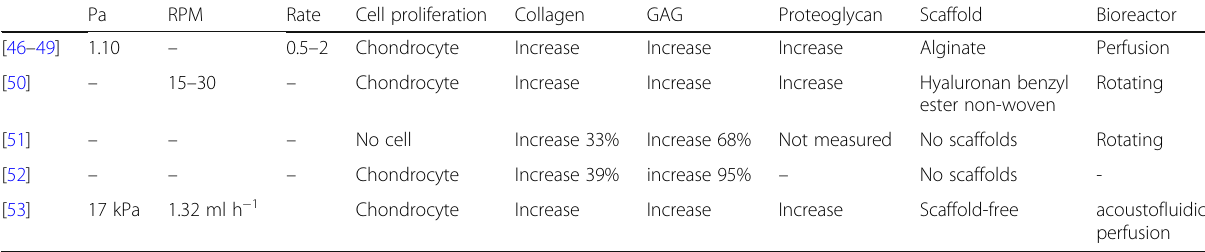
Table 8 Effect of perfusion bioreactor with low shear on chondrocyte proliferation and matrix composition